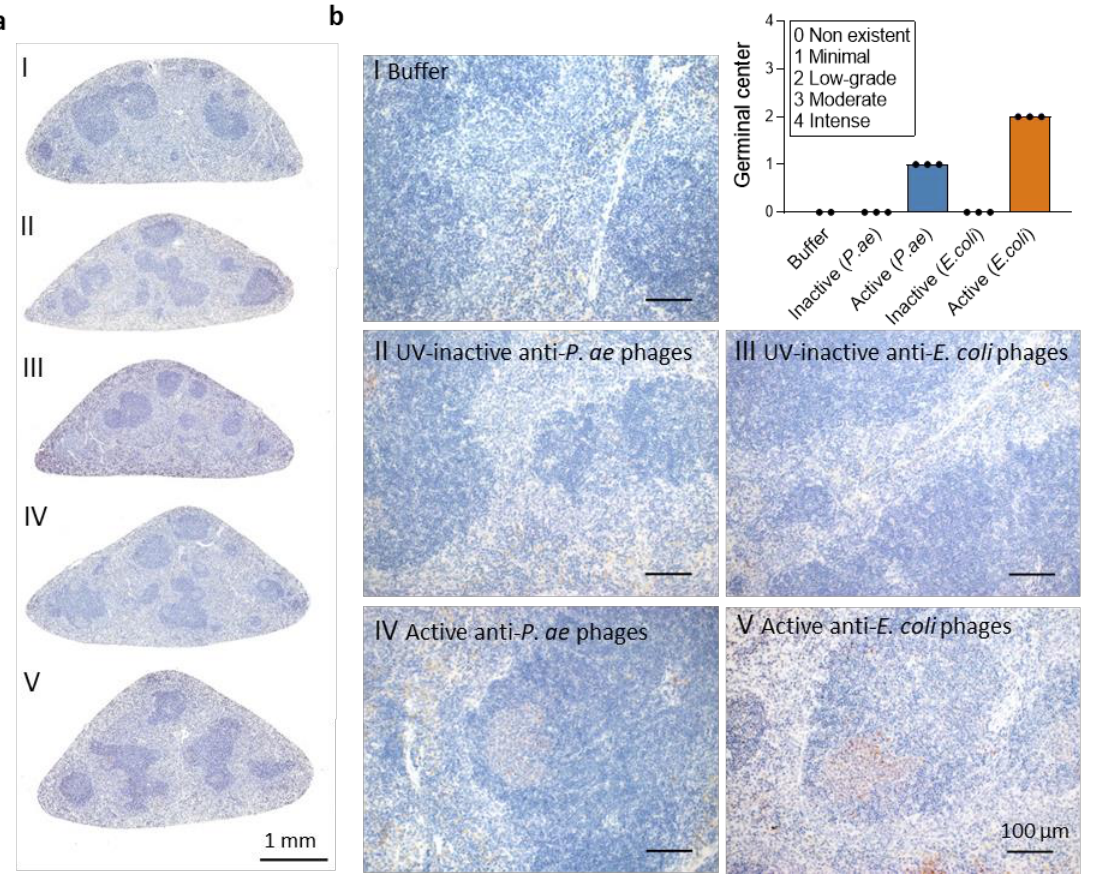
Figure 7. Phage treatment induces minimal to low-grade germinal center formation. Immunohistochemical staining of germinal center B cells (αGL -7 antibody; red) and hematoxylin (blue). Representative spleen sections ( a ) and corresponding enlarged images (( b ), 20×) from animals at 21 d after start of treatment with (I) buffer, (II) UV-inactive anti- P. aeruginosa phage cocktail, (III) UV-inactive anti- E. coli phage cocktail, (IV) active anti- P. aeruginosa phage cocktail and (V) active anti- E. coli phage cocktail. Bar graph showing germinal center formation scores; n = 2 – 3 mice per group.